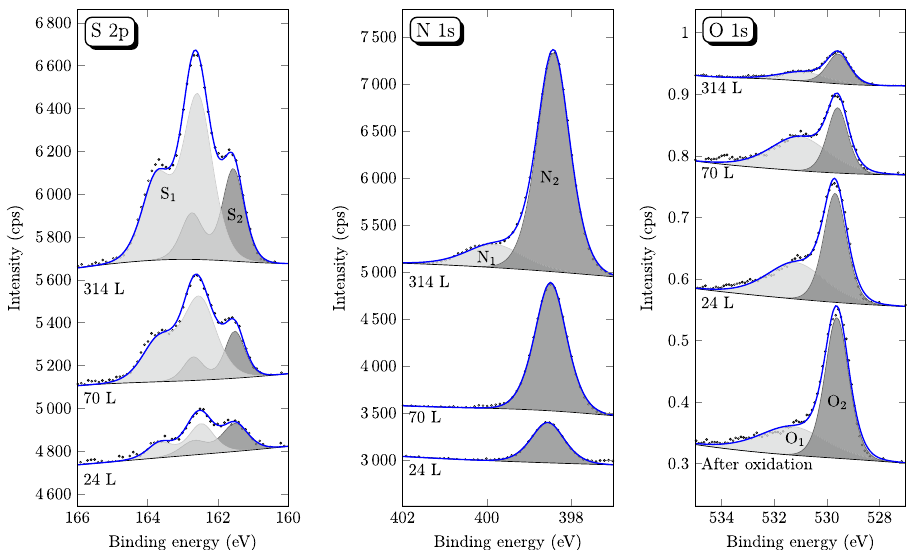
Fig. 5 High resolution XPS spectra obtained after 2-MBI exposure on pre-oxidized Cu(111) surface (2D oxide) at ultra-low pressure and RT. The S 2p, N 1s and O 1s core